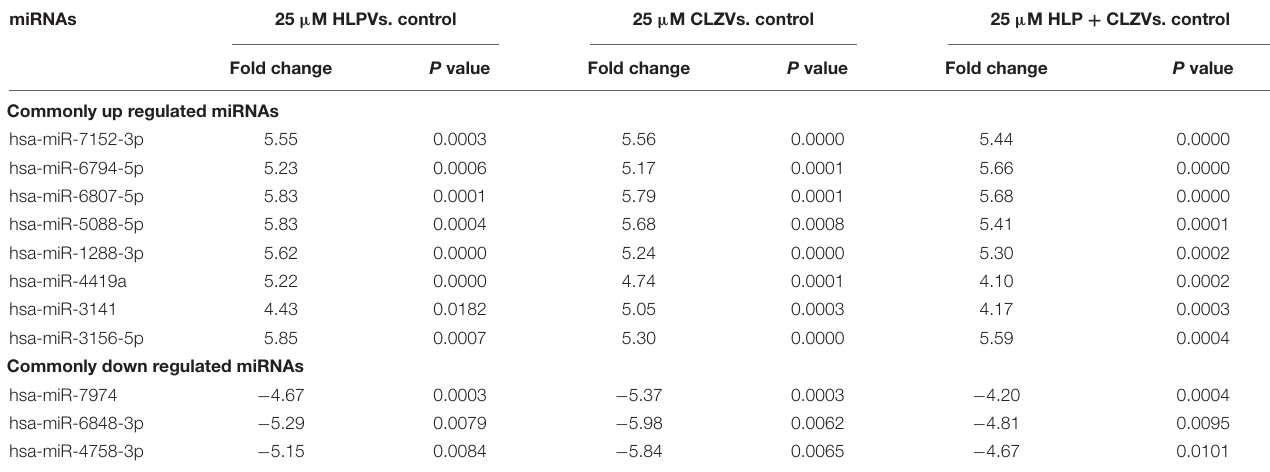
FIGURE 3 | Venn diagram representing the number of miRNAs upregulated (A) and downregulated (B) in each drug treatment condition. TABLE 2 | miRNAs that are commonly but significantly upregulated and downregulated in all antipsychotic drug treatment groups.